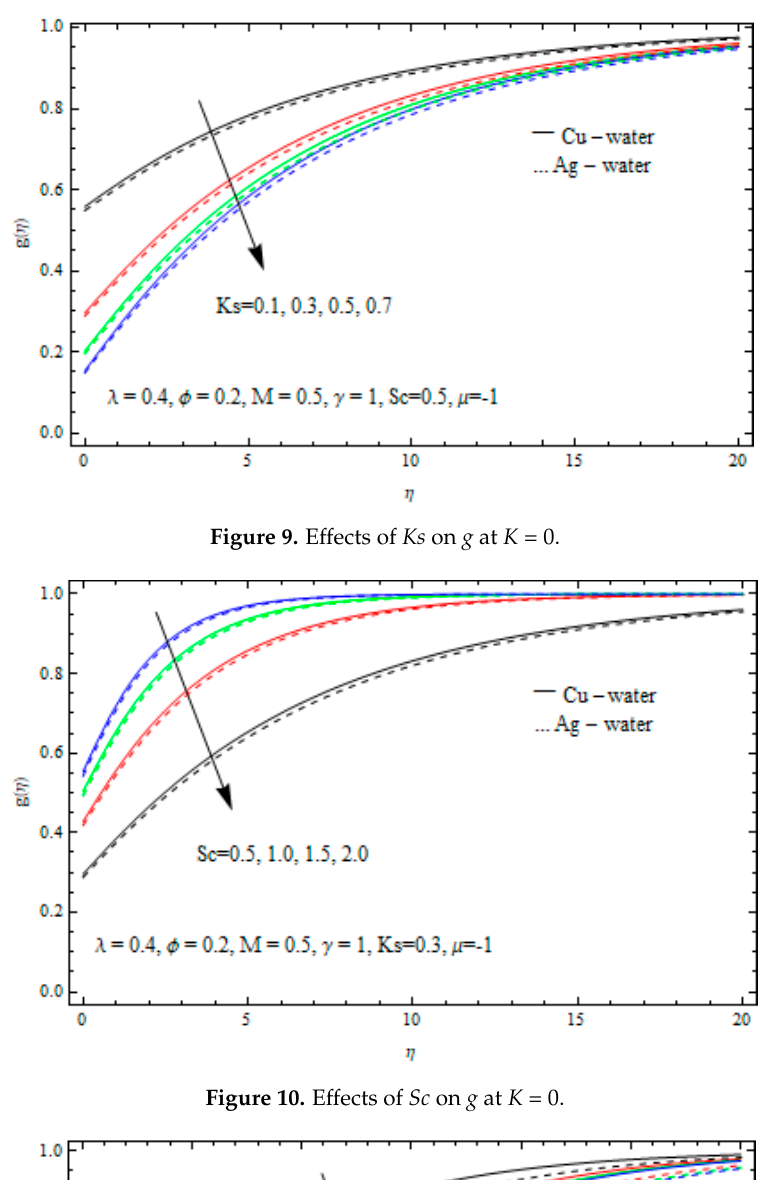
Figure 8. Effect of second slip on velocity of SiO 2 -water, Al 2 O 3 -water, and TiO 2 -water nanofluids.